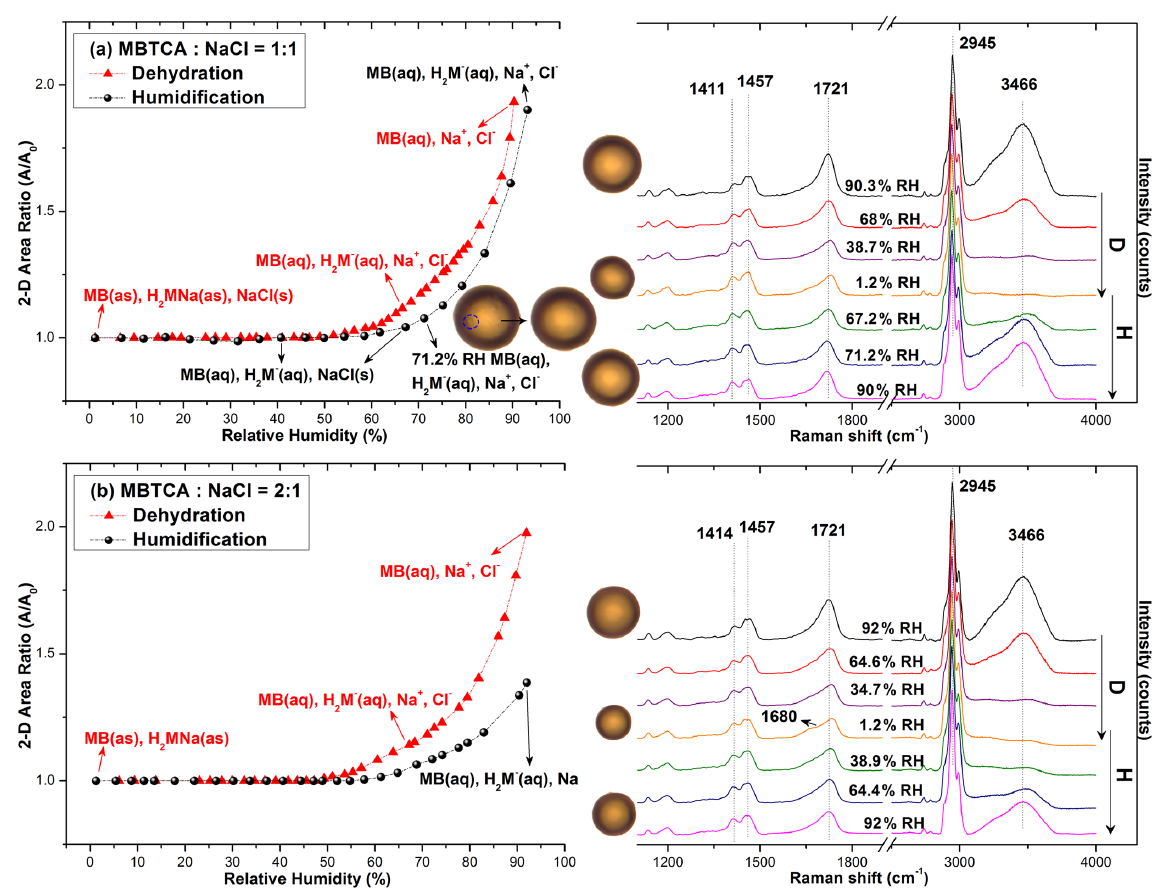
Figure 4. Hygroscopic curves, corresponding optical images, and Raman spectra at specific RHs of MBTCA:NaCl = (a) 1:1 and (b) 2:1. The recorded transition RHs during the dehydration (D) and humidification (H) processes and the chemical compositions of the mixtures at certain RHs are marked with arrows in the hygroscopic curves. The phase notations shown in parentheses are s – solid, aq – aqueous, and as – amorphous